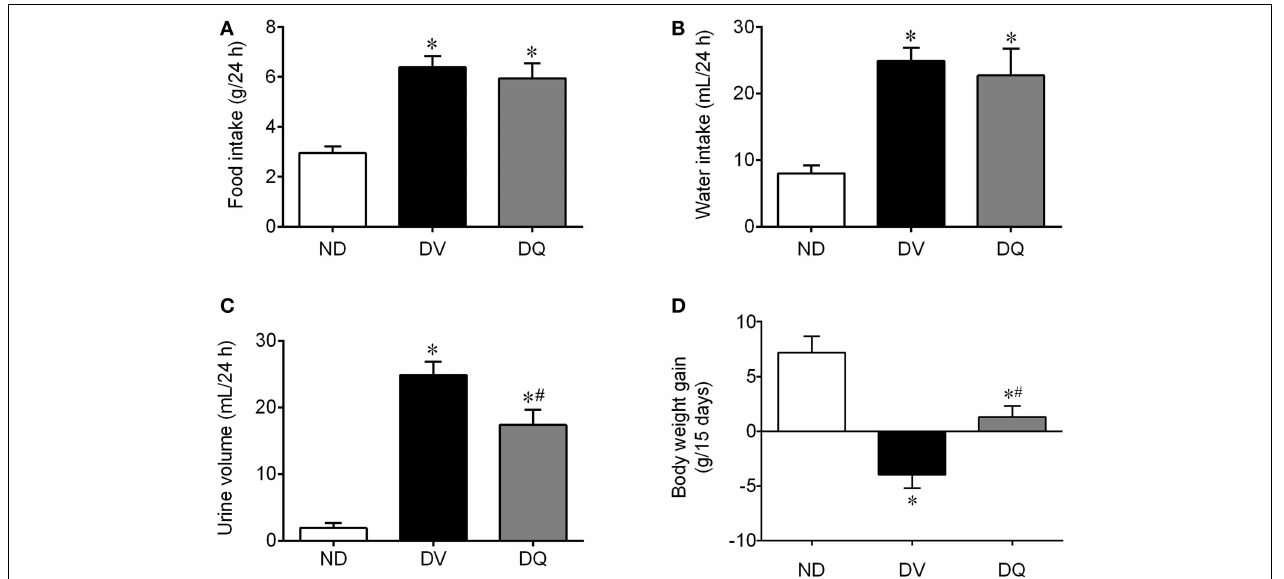
FIGURE 1 | Food and water intake, urine volume and body weight gain in diabetic apoE − / − mice treated with quercetin (DQ) compared with diabetic apoE − / − mice administered vehicle (DV) compared with non-diabetic apoE − / − (ND) mice. Values are the means ± SEM for n = 6 –8 mice per group. * p < 0 . 05 vs. ND, # p < 0 . 05 vs. DV.